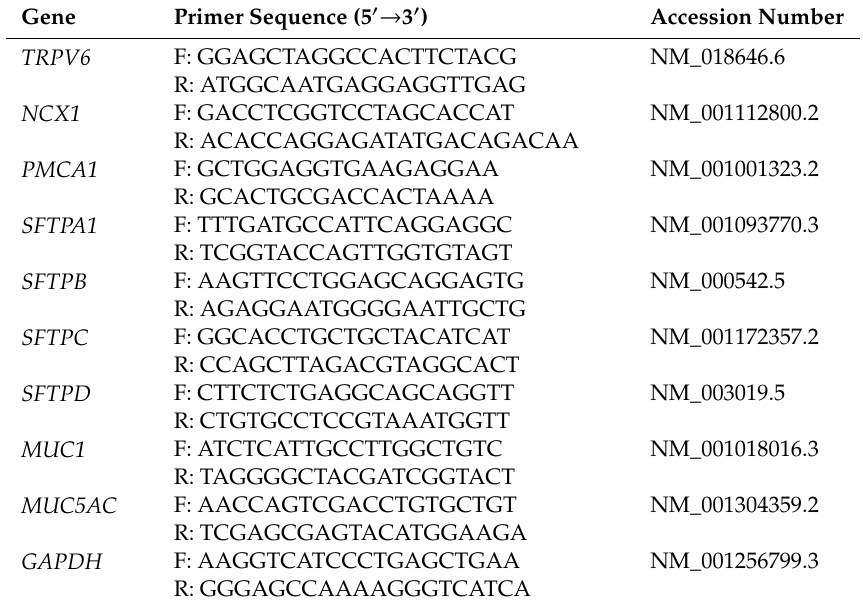
Table 1. Oligonucleotide sequences for quantitative real-time